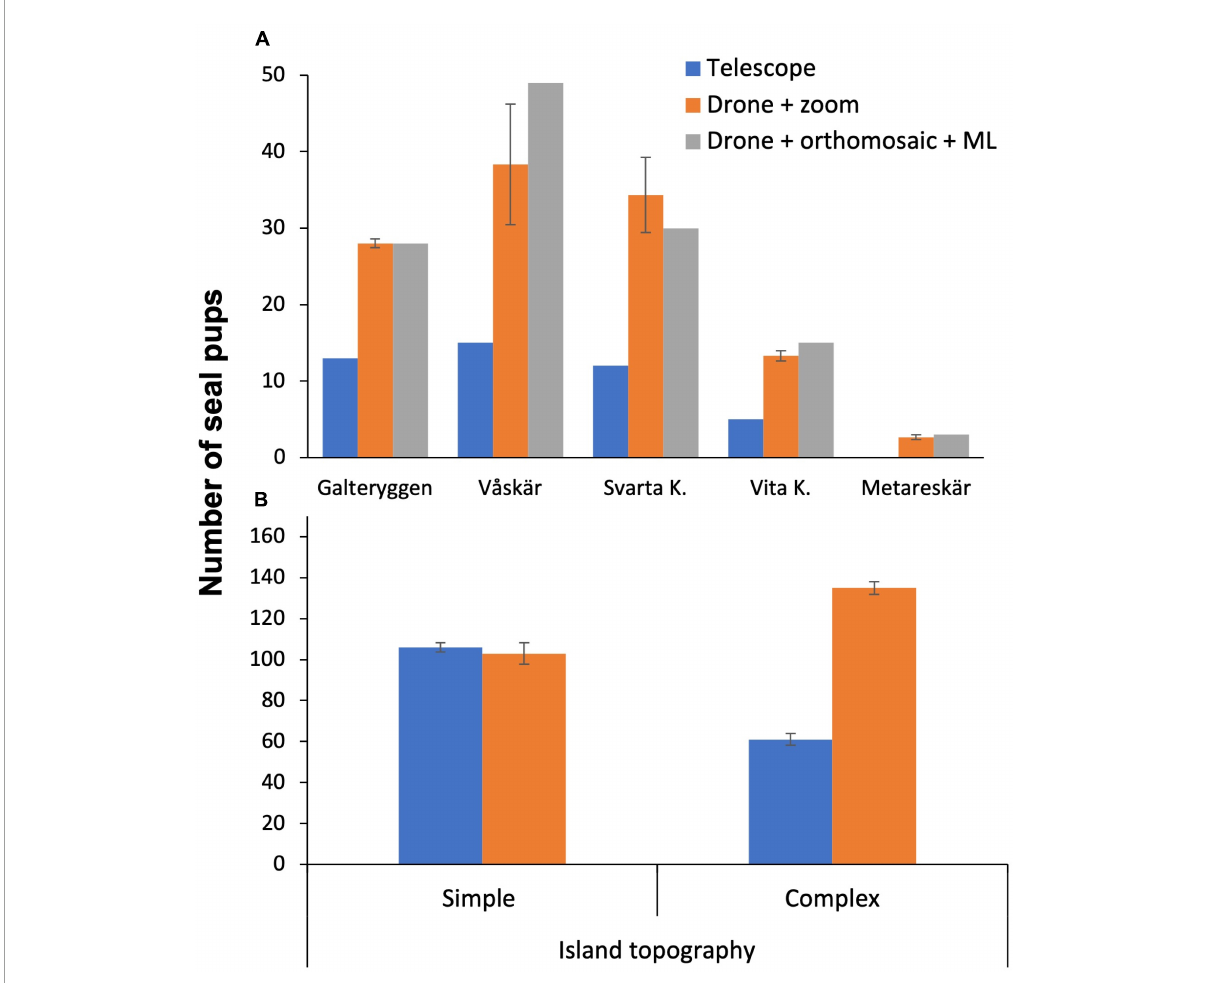
FIGURE4 (A) Comparison between survey methods implemented at 5 sites, (B) number of pups counted with telescope and drone at simple and complex island topographies. Seal counts at islands with complex topography showed a significant difference between methods, F = 209.461, p < 0.05. Data collected during 13 and 16 of June